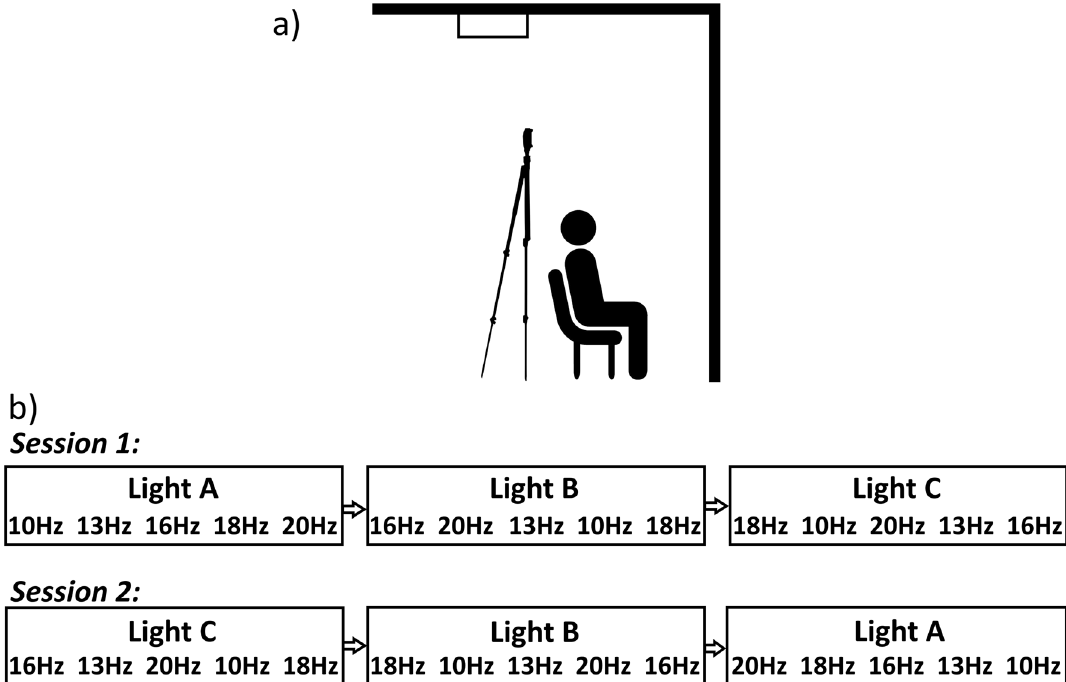
Figure 1. ( a ) Positioning of lighting and test subject. The test subject was seated so that the front wall filled their entire field of view (no parts of either side wall were visible). The light stand was positioned so that no shadows were visible in the subject’s field of view. The photopic lighting condition was achieved by activating the fixed fluorescent ceiling light with no light stand used, while all other lighting conditions (the mesopic condition and the brief periods requiring light in the dark condition) were achieved using the light stand only. ( b ) Example sequence of the block design across both sessions. For the first session, each lighting condition block was and the frequencies within those blocks were